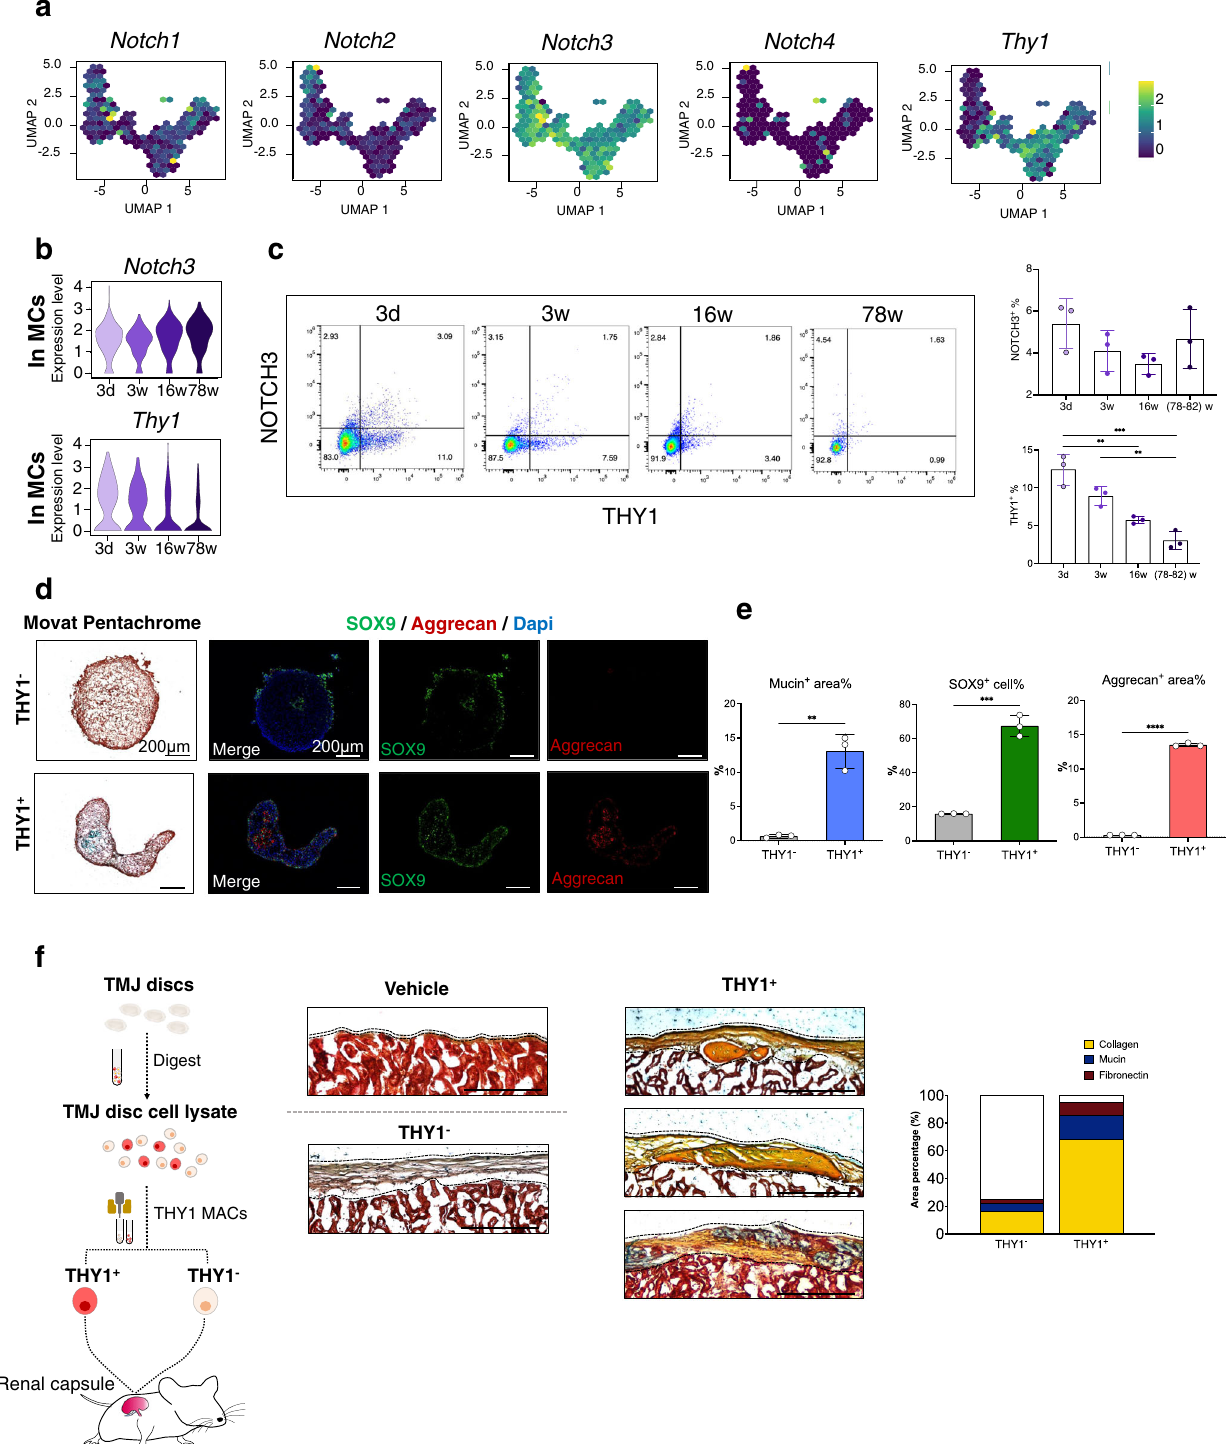
Fig. 6 | THY1+/NOTCH3+ mural cells in TMJ discs show skeletal progenitor capacities. a Normolized expression of Notch families and Thy1 visualized in reclustered MCs in low-dimensional space with schex. b Violin plot of Notch3 and Thy1 at different stages. c Flow cytometry plot of THY1 + /NOTCH3 + cells (left). % THY1 + /NOTCH3 + cells (mean+/-SD) are presented (right). N =3 independent biological samples. The one-way ANOVA with Tukey ’ s multiple comparison test was used for analysis, ** (3d vs. 16w) p =0.0014, ** (3w vs. 78-82w) p =0.0033, *** p =0.0033. d Pentachrome staining: Black: nuclei/elastic fi bers, bright blue: mucin, and bright red: fi brin. Immuno fl uorescence staining: red: ACAN; green: